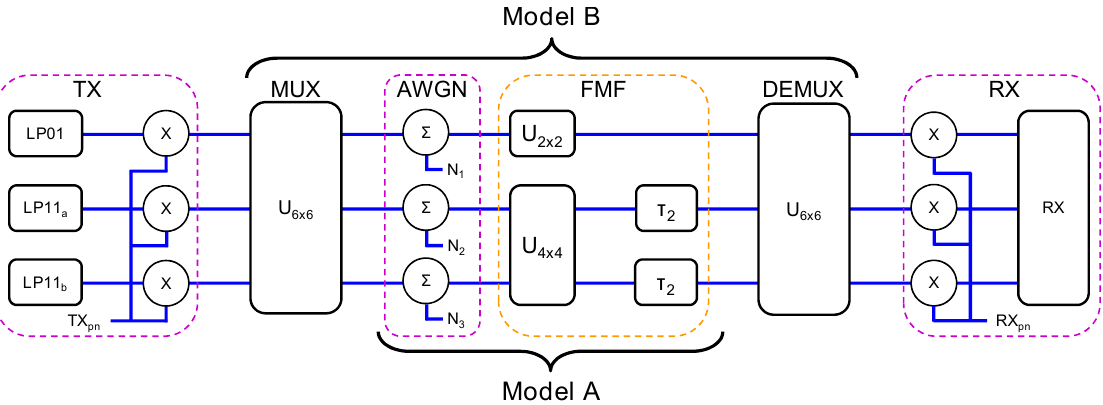
Figure 3. Simplified simulation diagram for model A and model B. In model A, the MUX and DEMUX are modeled with rank 6 identity matrices whereas in model B the DE/MUXes are modeled with rank 6 random complex unitary matrices. Additive white Gaussian noise (AWGN), receiver